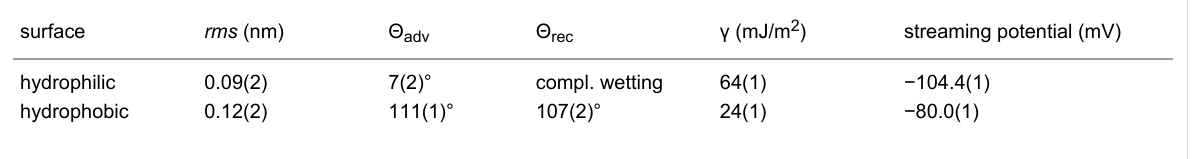
Table 1: Parameters of the model substrates: Root mean square ( rms ) roughness, advancing (adv) and receding (rec) contact angles Θ of water, surface energy γ (values taken from [21]) and surface charge as revealed by streaming potential measurements at pH 7.3 [22].